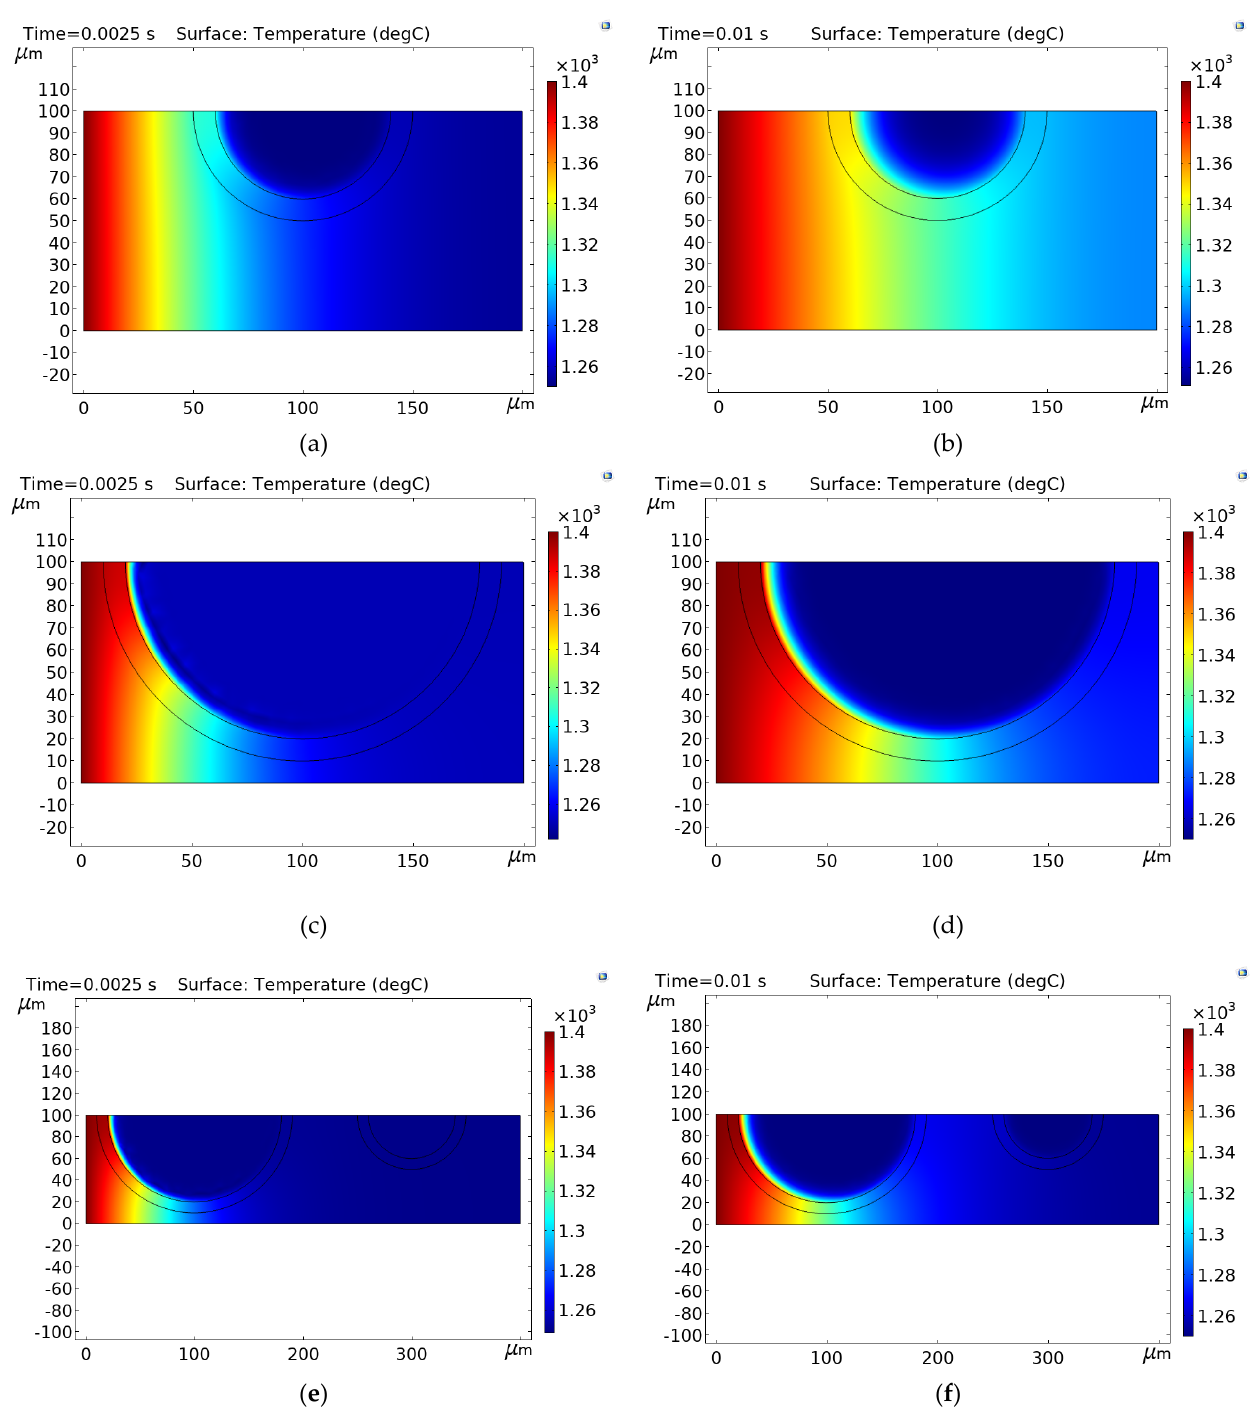
Figure 8. Graphical distribution of the temperature magnitudes in: ( a ) Composite 1 over x-z plane at time instant t 1 ; ( b ) Composite 1 over x-z plane at time instant t 2 ; ( c ) Composite 2 over x-z plane at time instant t 1 ; ( d ) Composite 2 over x-z plane at time instant t 2 ; ( e ) Composite 3 over x-z plane at time instant t 1 ; ( f ) Composite 3 over x-z plane at time instant t 2